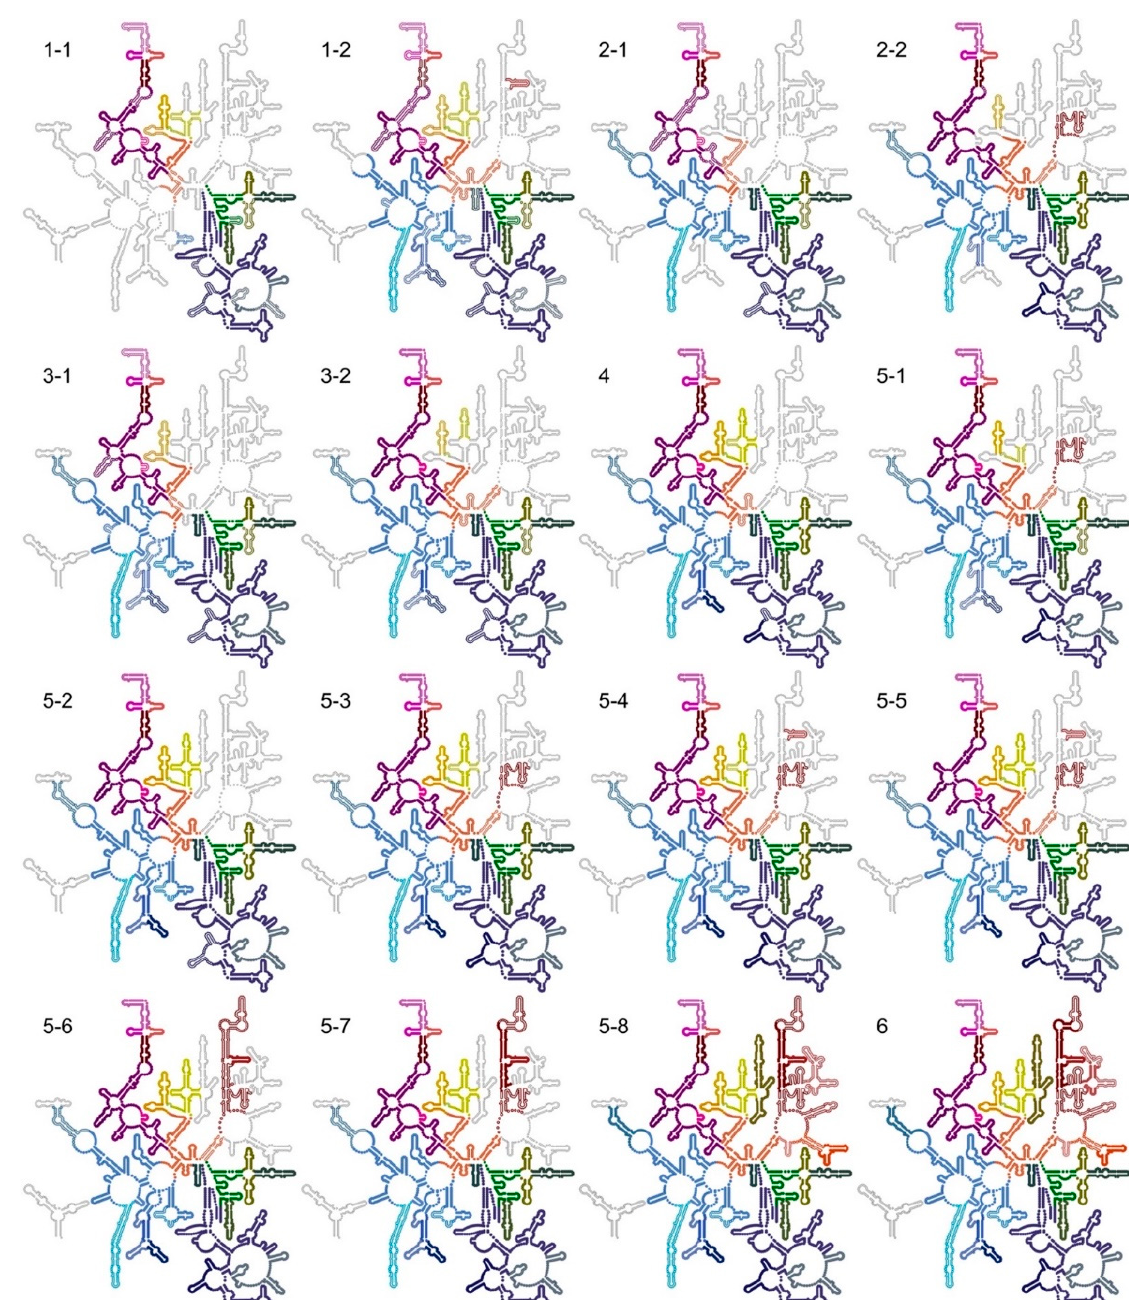
Figure 4. Ordered rRNA for all particle classes mapped on the secondary-structure map of the LSU (adapted with permission (CC BY-SA 3.0) from Ref. [34]). Ordered RNA helices are colored according to Figure 2b. Partially ordered helices have half-filled circles (lighter color) and disordered helices are